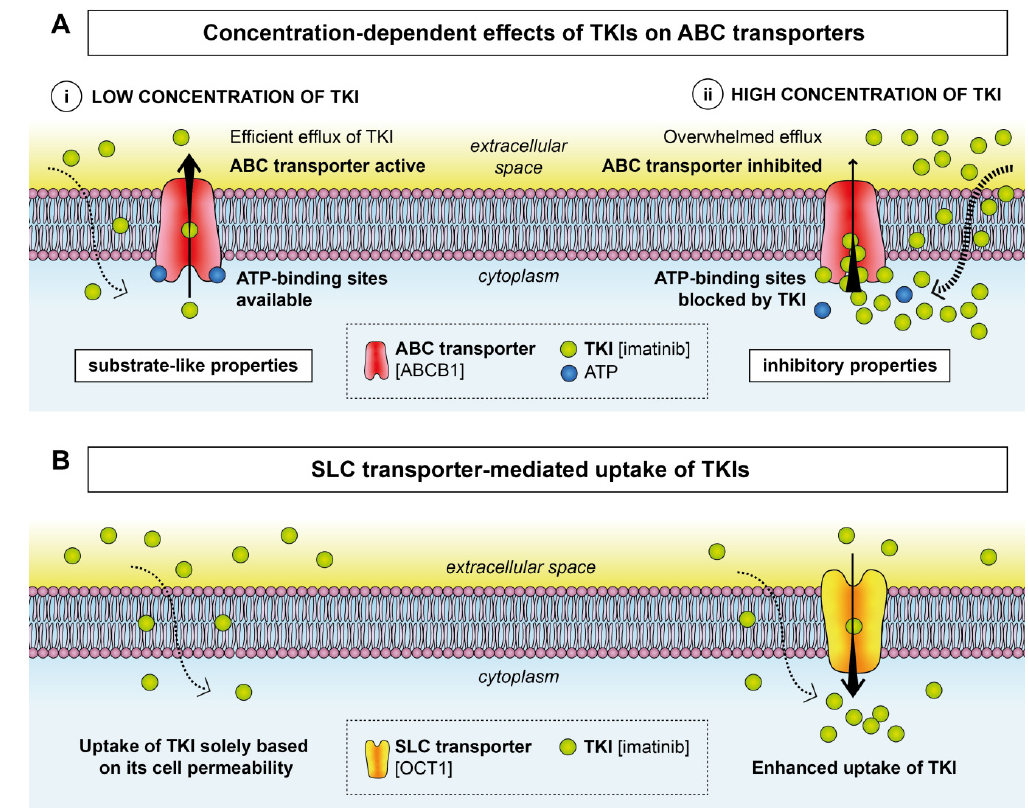
Figure 1. Transport of TKIs by ABC and SLC transporters. ( A ) At low concentrations ( i ), some TKIs exhibit substrate-like properties and are exported out of the cell by the respective ABC transporters.